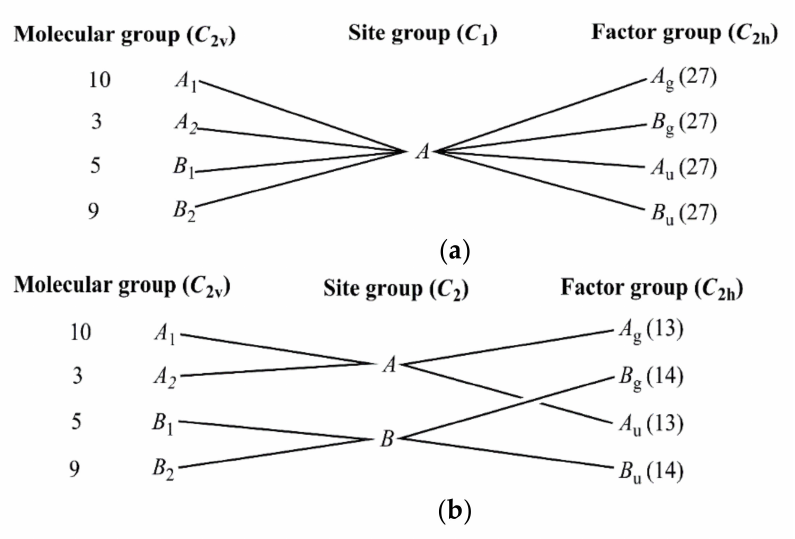
Figure 8. Correlation table for the 27 internal vibrational modes of the coordinated type of pyridine rings at C 1 ( a ) and C 2 ( b )